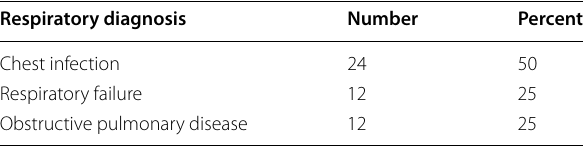
Table 3 Percentage distribution of the studied subjects who